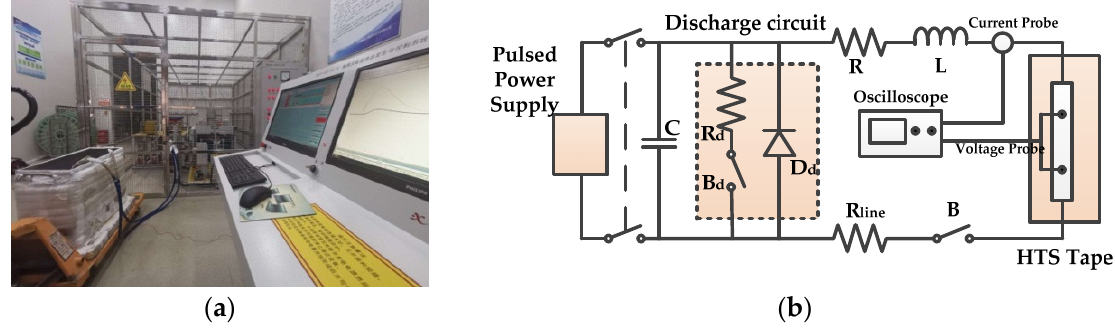
Figure 2. ( a ) Transient current experiment platform; ( b ) circuit diagram.